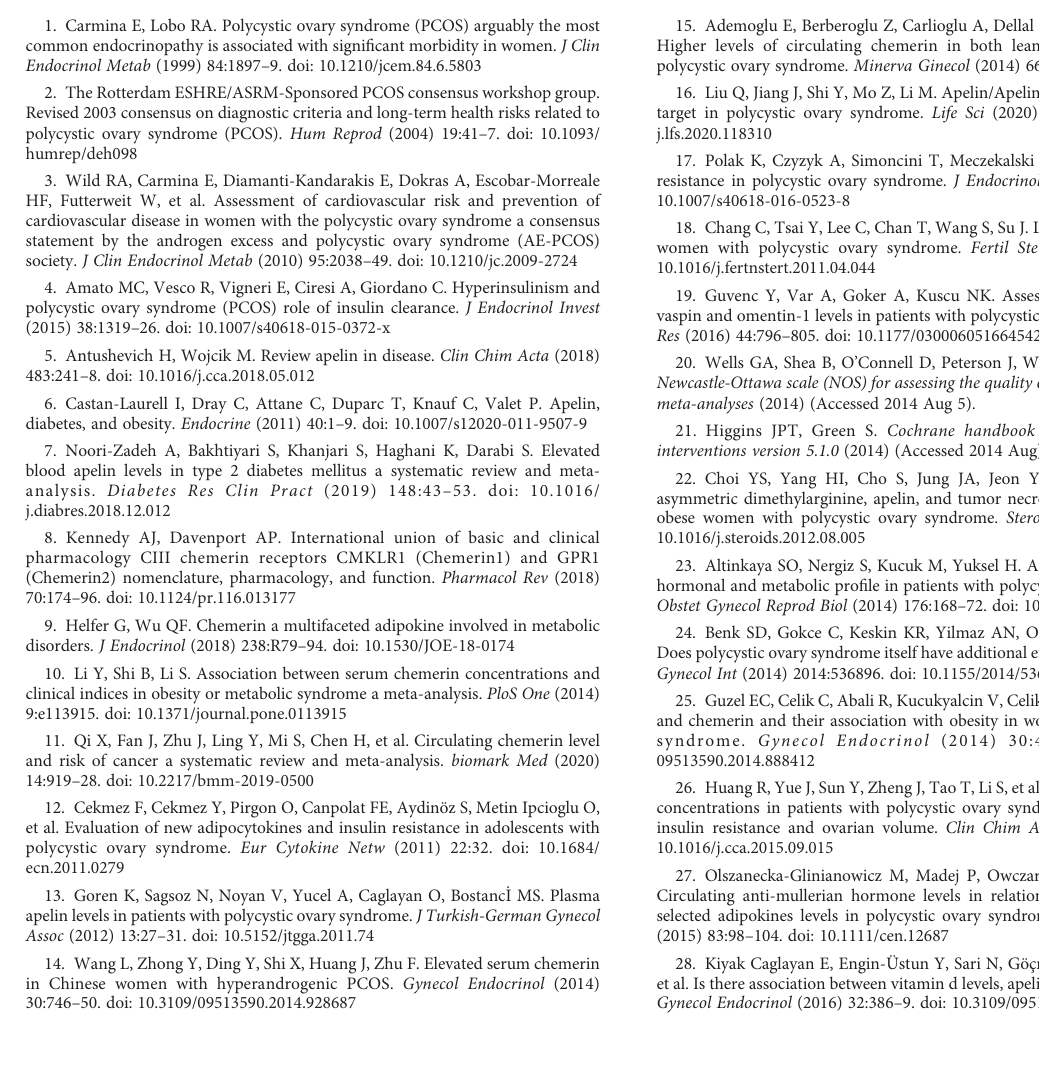
SUPPLEMENTARY FIGURE 1 The funnel plots of circulating apelin levels in patients with polycystic ovary syndrome compared with controls. SUPPLEMENTARY FIGURE 2 The funnel plots of circulating chemerin levels in patients with polycystic ovary syndrome compared with